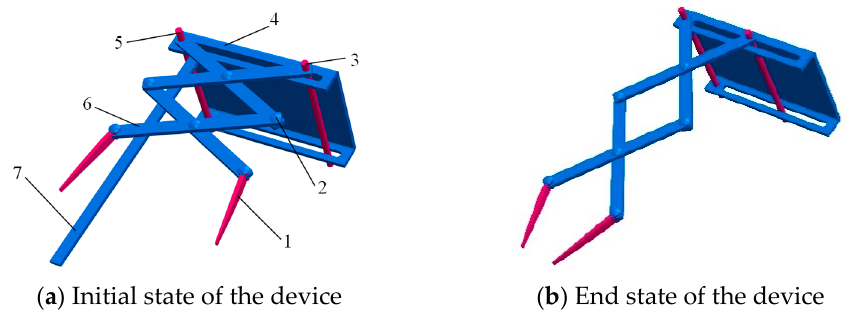
Figure 1. Structure diagram of the seedling pick ‐ up device: 1, needle; 2, pins; 3, sliding rod; 4, upper plate; 5, fixed rod; 6, stretchable slice; 7, withdraw rod.